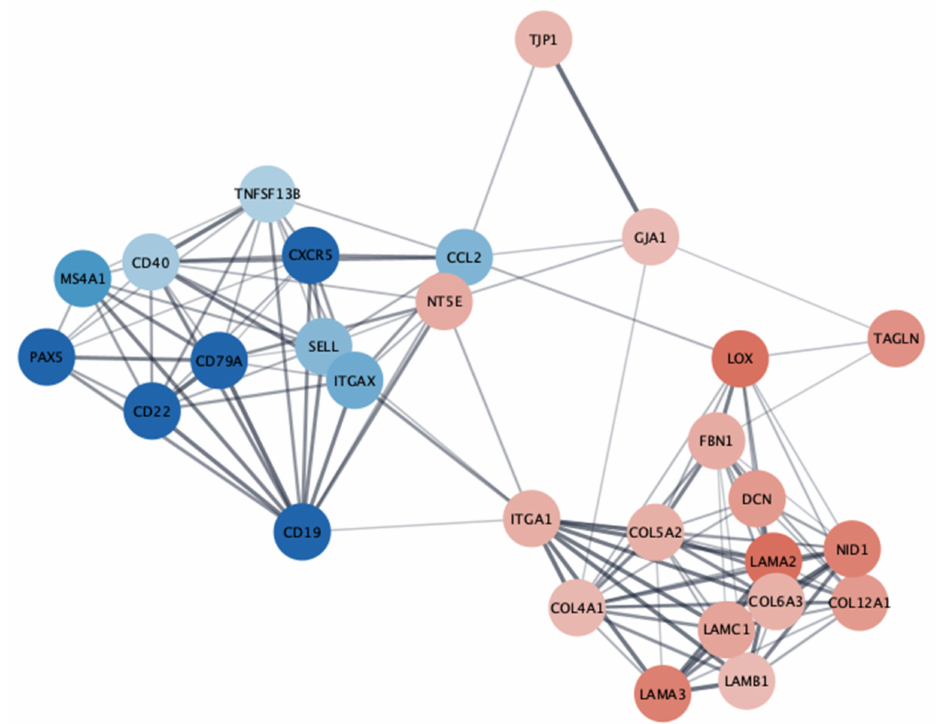
Figure 7. Interaction network of the 28 identified hub genes. The fill color corresponds to log2 fold change estimated by DESeq2, with blue indicating negative changes and red indicating positive changes in the high-Twist1-expression group relative to the low-expression group (created using the Cytoscape software). CCL2 , C–C motif chemokine ligand2; CD , cluster of differentiation; COL5A2